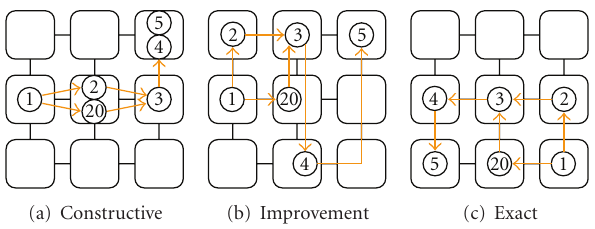
Figure 9: Comparison of constructive, improvement and exact